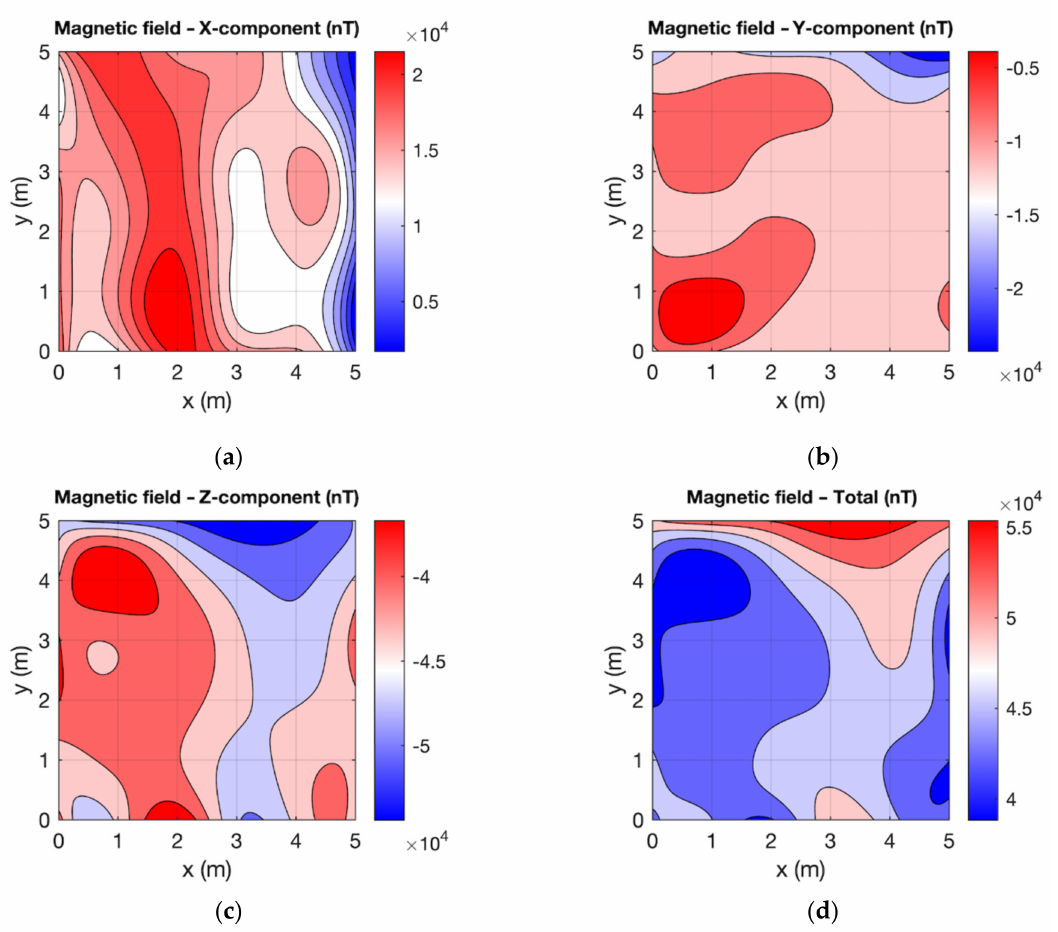
Figure 10. Magnetic field measured by the VEMA magnetometer: ( a ) X-component; ( b ) Y-component; ( c ) Z-component; ( d )